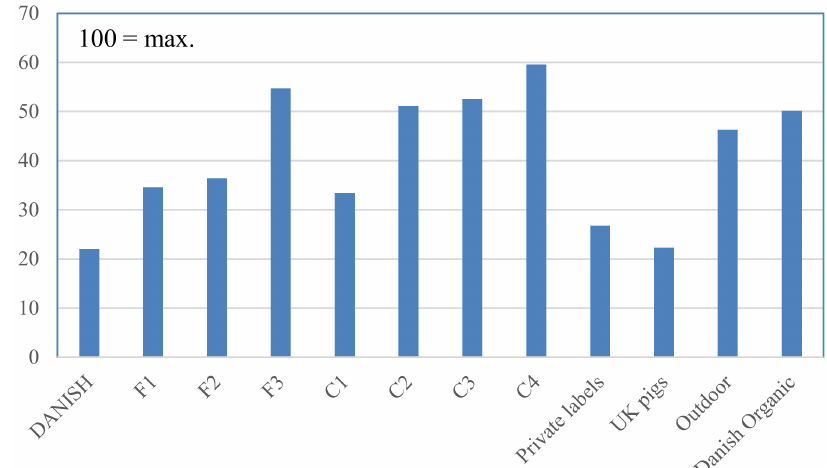
Figure 1. The calculated Benchmark-values (on a scale from 0 to 100) of the di ff erent Danish animal welfare initiatives relating to pigs: DANISH is an industry label that from a welfare perspective mainly guarantees compliance with Danish law, F1–F3 are three levels of the o ffi cial welfare label “Bedre Dyrevelfærd”, C1–C4 are four levels of the retail welfare label “Dyrevelfærdshjertet”, Private labels are some older labels with limited focus on animal welfare, UK pigs complies with the Red Tractor label in the UK, Outdoor is a form of production where sows are housed in outdoor farrowing huts and where finishers have outdoor access, and Danish Organic is a form of outdoor production that complies with the Danish organic standards that are slightly above European Union (EU) requirements for organic production (requiring weaning age of 49 days as compared to the EU requirements of 40